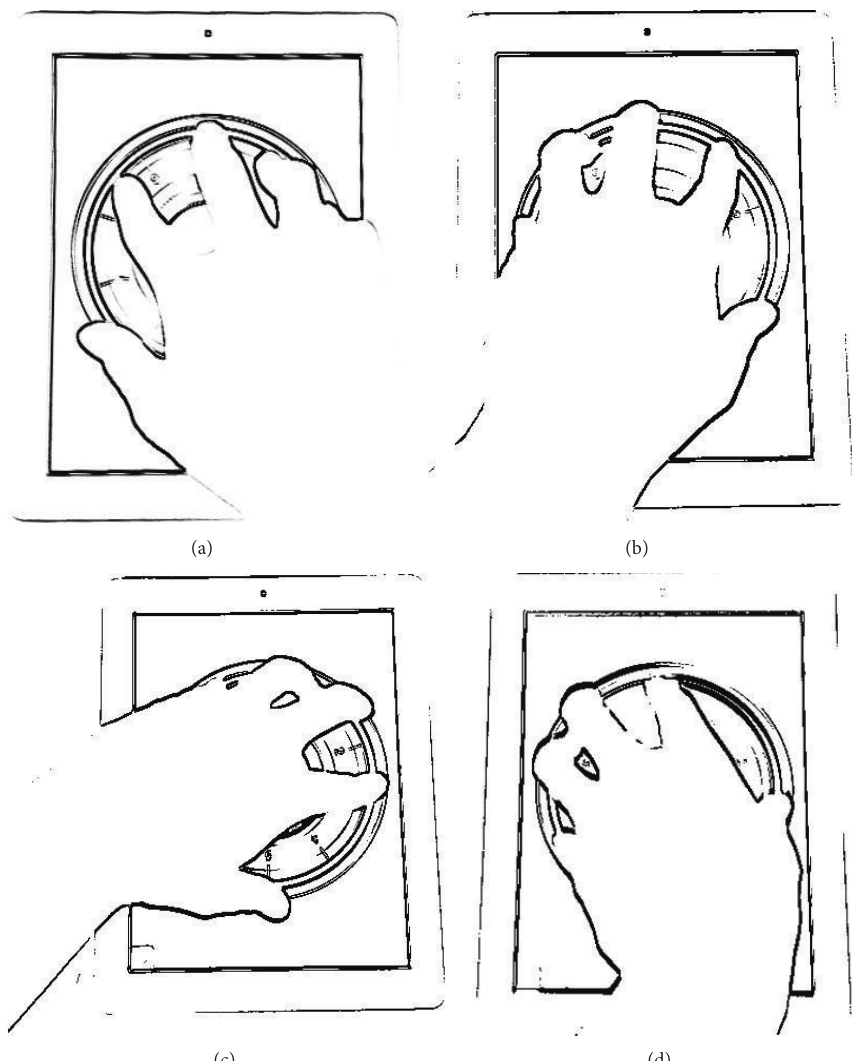
Figure 3: An example of behavioral biometrics. (a) Presents a right-handed user. (b) Presents a left-handed user. (c) Presents a left-handed user with clockwise rotation. (d) Presents a left-handed used with counterclockwise